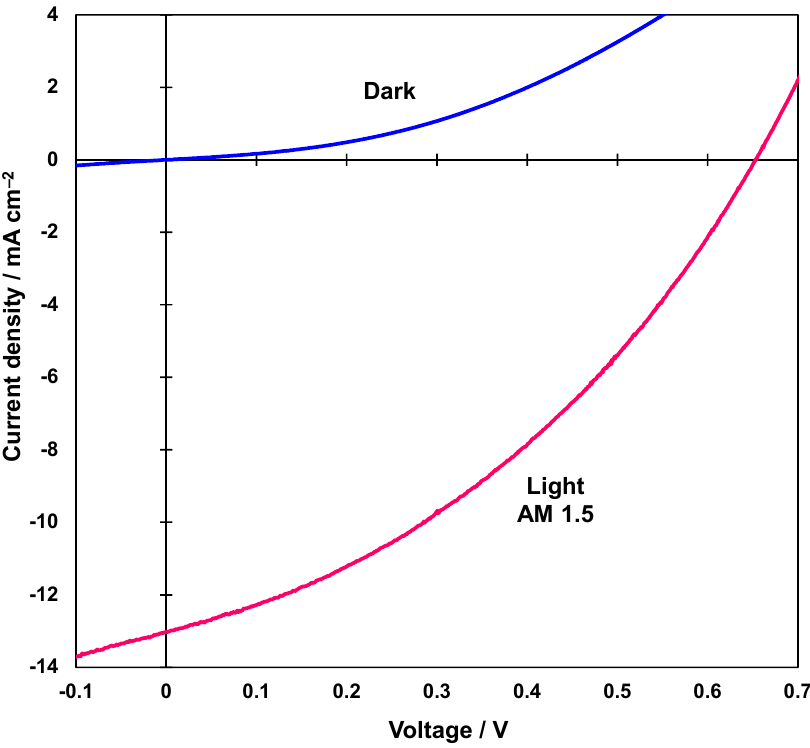
Figure 3. Measured J - V characteristics of TiO 2 /CH 3 NH 3 PbI 3 photovoltaic cell in the dark and under illumination.